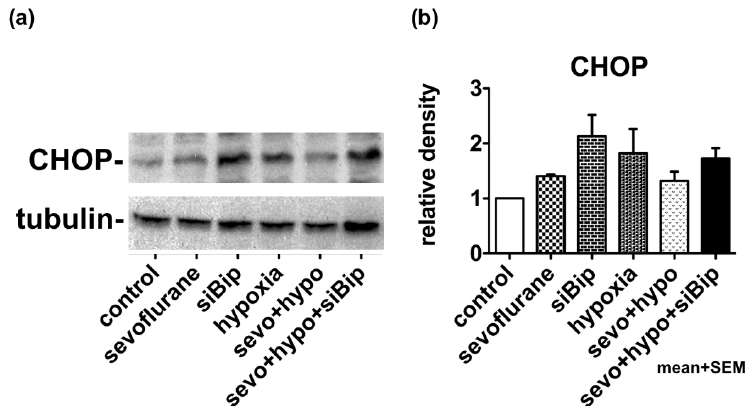
Figure 3. Pre-exposure to sevoflurane may induce the UPR and reduce the damage caused by hypoxia. ( a ) Cells were exposed to 3% sevoflurane for 5 h. After 12 h of recovery time, cells were exposed to hypoxic conditions (1% O 2 ) for 17 h before collection. Hypoxia alone induced the expression of CHOP. Pre-exposure to sevoflurane reduced the expression of CHOP while siBiP enhanced the expression of CHOP. ( b ) Densitometry was performed for three experiments. The density of CHOP relative to that of tubulin was measured by Image J and analyzed by one-way analysis of variance (ANOVA) followed by Dunnett’s multiple comparison test. Values indicate mean + standard error of the mean (SEM). Control vs. siBip; p < 0.05.